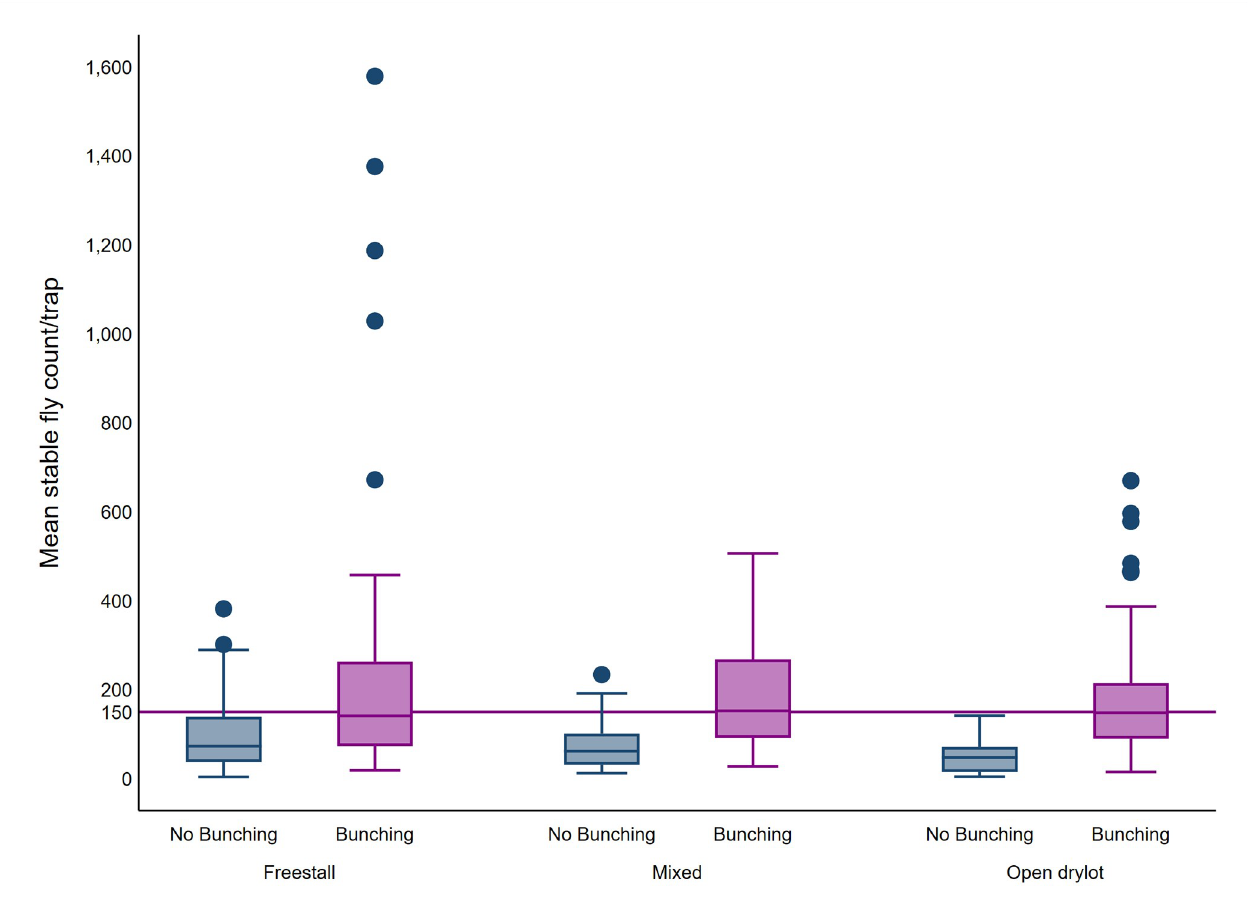
Fig 3. Boxplot of average stable fly count on cow leg by bunching, time of day and pen design. The upper and lower horizontal lines of the box represent the 25 th and 75 th percentiles respectively, the horizontal midline represents the median, the upper and lower horizontal whiskers lines are the upper and lower limits and the dots are the